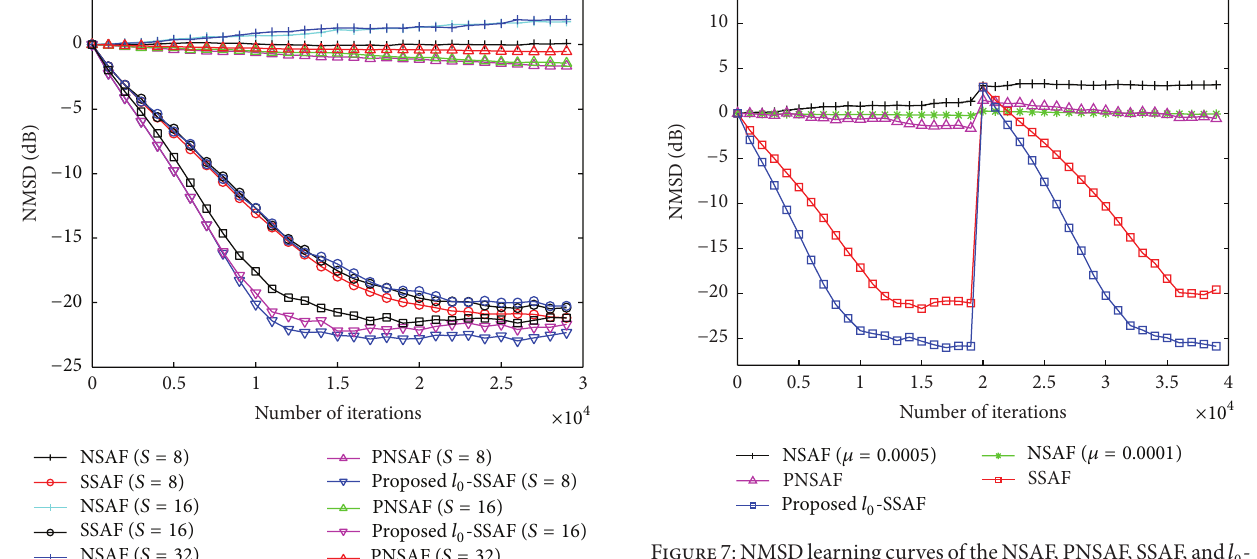
Figure 7: NMSD learning curves of the NSAF, PNSAF, SSAF, and 𝑙 0 - SSAFalgorithmsincaseofatime-varyingunknownsystem( 𝑁 = 4 ). The system is right-shifted for 20 taps at 20000th iteration [ 𝑁 = 4 , SIR = −30 dB, input: Gaussian AR (1) with pole at 0.9].